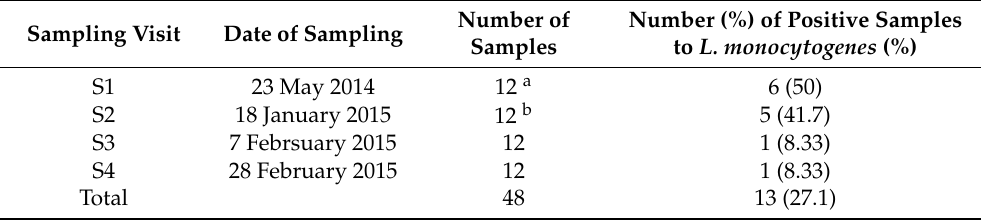
Table 1. Bacteriological detection of L. monocytogenes in samples from swine slaughterhouse conveyor surfaces collected after cleaning and sanitation, by sampling